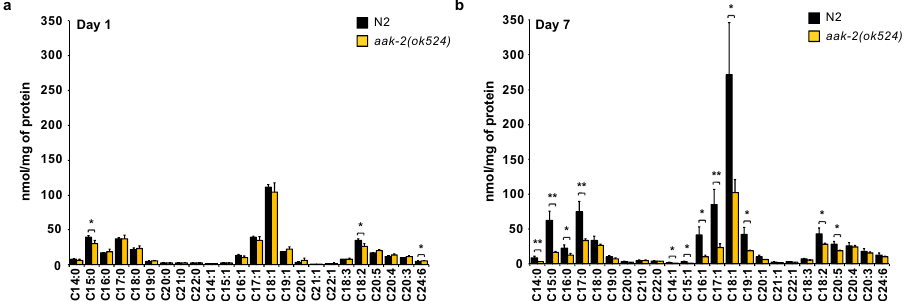
Figure 7. Metabolite profiles in young and aged aak-2 mutants. ( a ) In early adulthood (day 1), the abundance of FAs in aak-2 ( ok524 ) was similar to N2 worms. ( b ) While most FAs accumulated in aged N2 worms (day 7), this accumulation was attenuated in aged aak-2 ( ok524 ) worms, suggesting that this gene drives the observed age-related changes in lipid metabolism. Bar graphs are expressed as mean ± SD, Significance was calculated using Student’s t -test. * p ≤ 0.05; ** p ≤ 0.01; *** p ≤ 0.001; **** p ≤